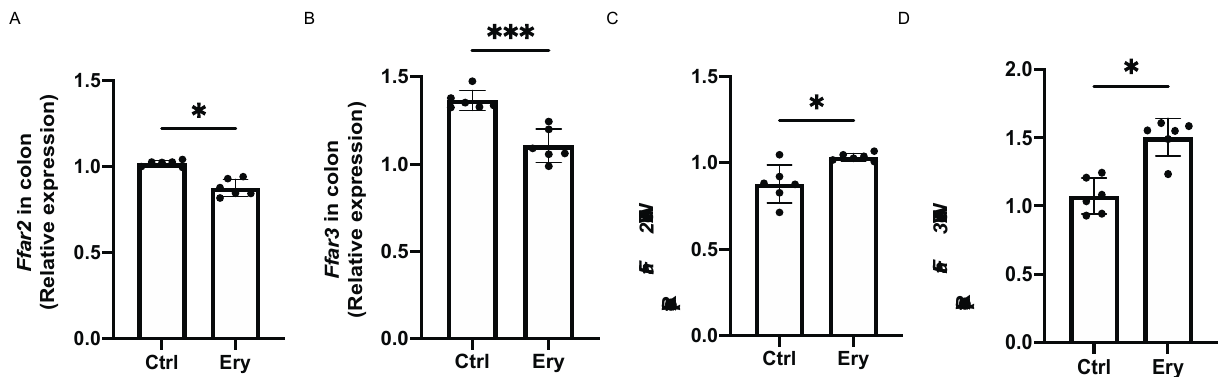
Figure 7. Erythritol decreased Ffar2 and Ffar3 expression in the colon and increased it in the eWAT. ( A ) Ffar2 and ( B ) Ffar3 gene expression in the colon ( n = 6). ( C ) Ffar2 and ( D ) Ffar3 gene expression ( n = 6) in the epididymal white adipose tissue (eWAT). Data have been represented in terms of mean ± SD values. * p < 0.05, ** p < 0.01, and *** p < 0.001, using an unpaired t -test.